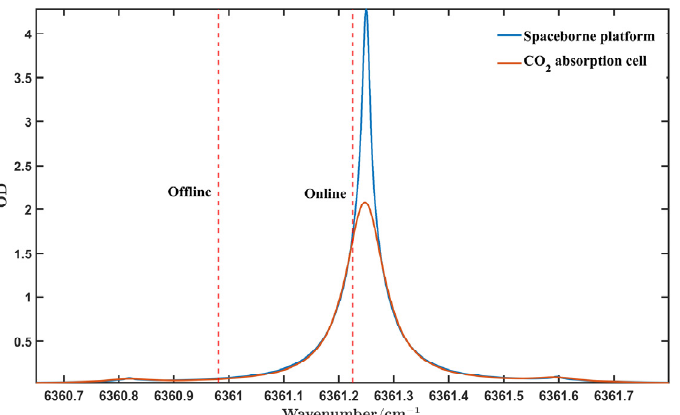
Figure 2. CO 2 optical depth of the spaceborne platform and the corresponding absorption cell.